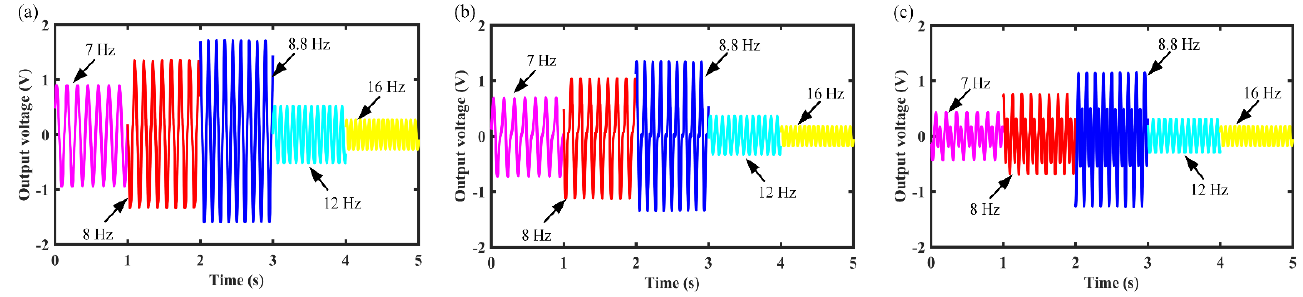
Figure 4. Output voltage of the MCEEH at different frequencies: ( a ) coil 1; ( b ) coil 2; ( c ) coil 3.